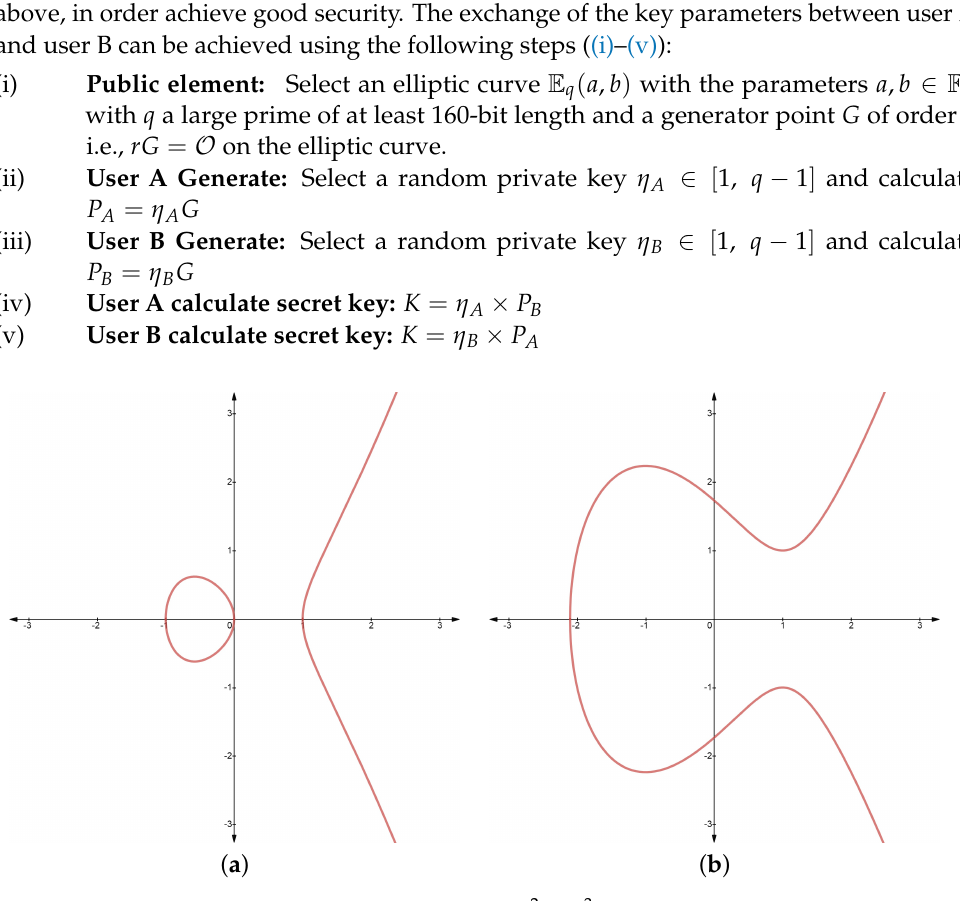
Figure 1. Elliptic curves over R . ( a ): Elliptic curve for y 2 = x 3 − 3 x + 3 over R , and ( b ): Elliptic curve for y 2 = x 3 − x over R